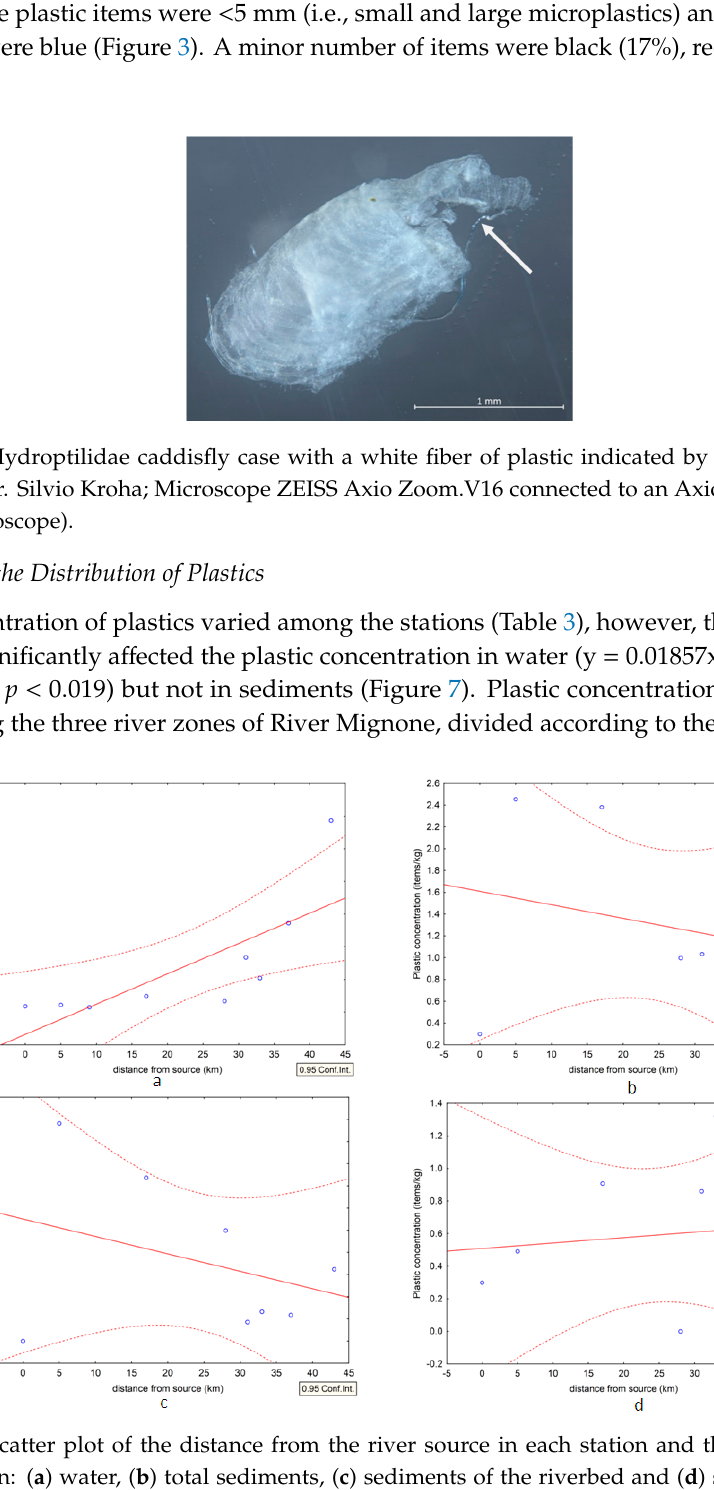
Figure 5. Frequency of grain size sediment for each station divided for riverbed (SE), left riverbank (SX) and right riverbank (DX). Gravel: particles > 2 mm, sand: 0.063 mm < particles < 2 mm, mud: particles < 0.063 mm.